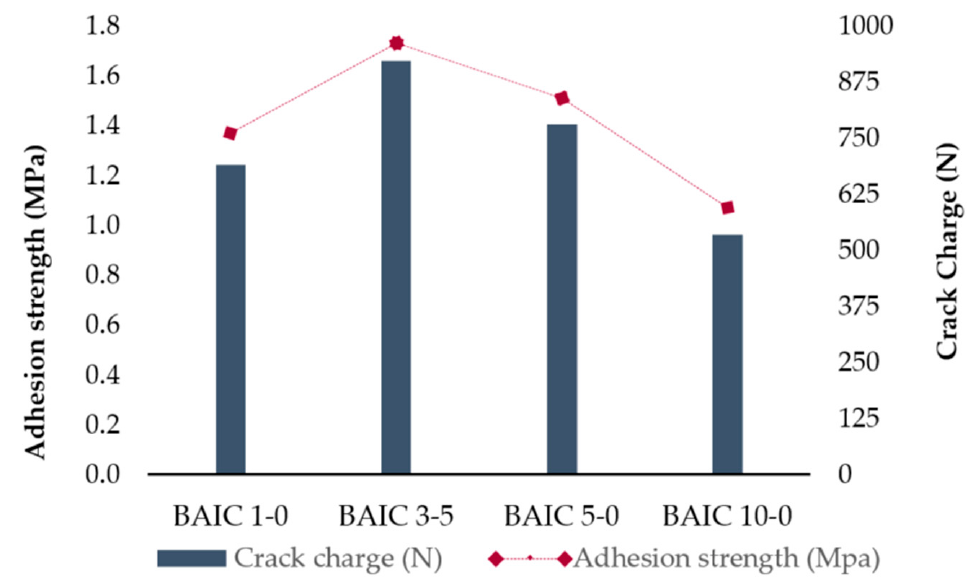
Figure 13. Crack charge and adhesion strength of BAIC c samples.